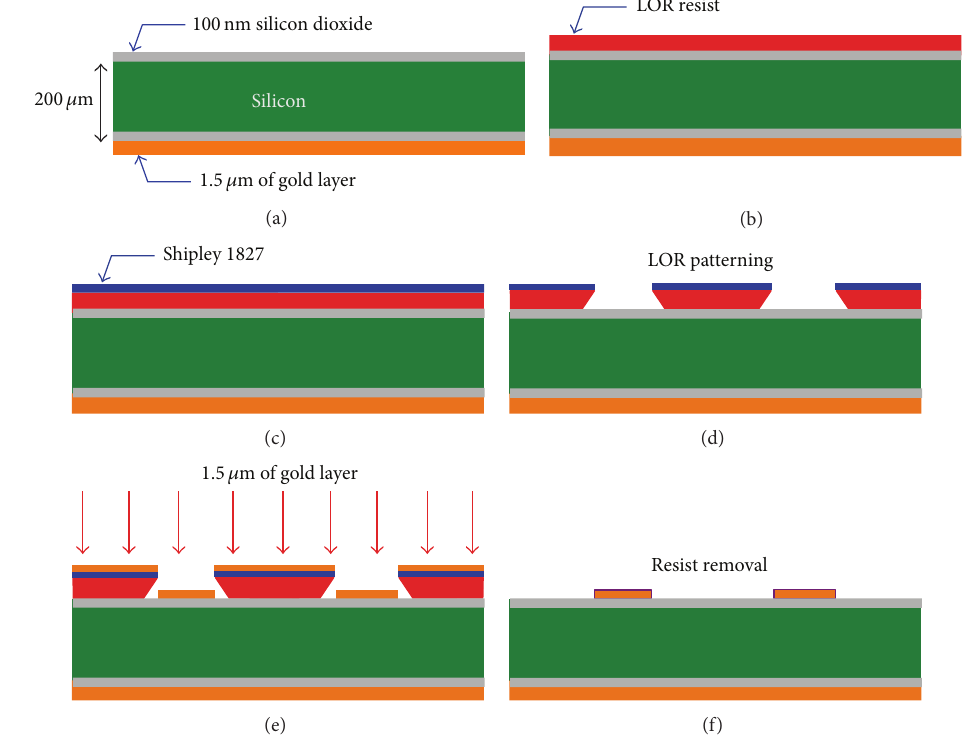
Figure 15: Fabrication steps of the proposed Rotman lens.